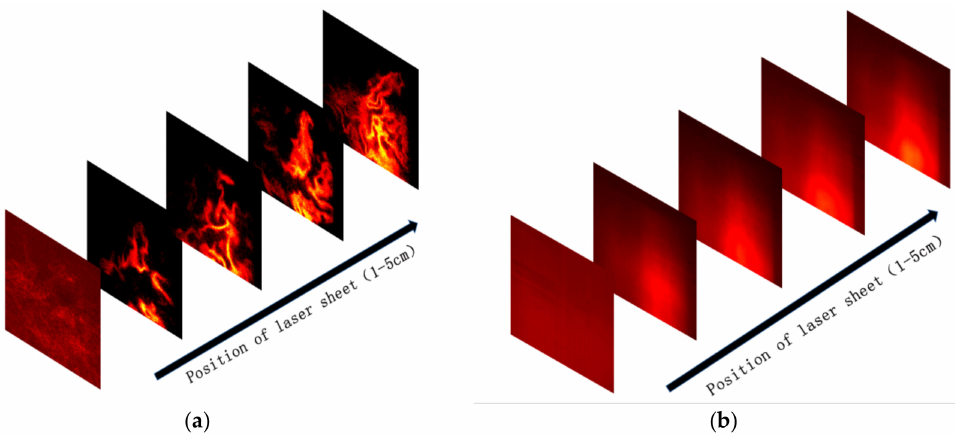
Figure 10. OH-PLIF images of different sheet positions. ( a ) OH-PLIF images in different positions; ( b ) the average of 1000 OH-PLIF